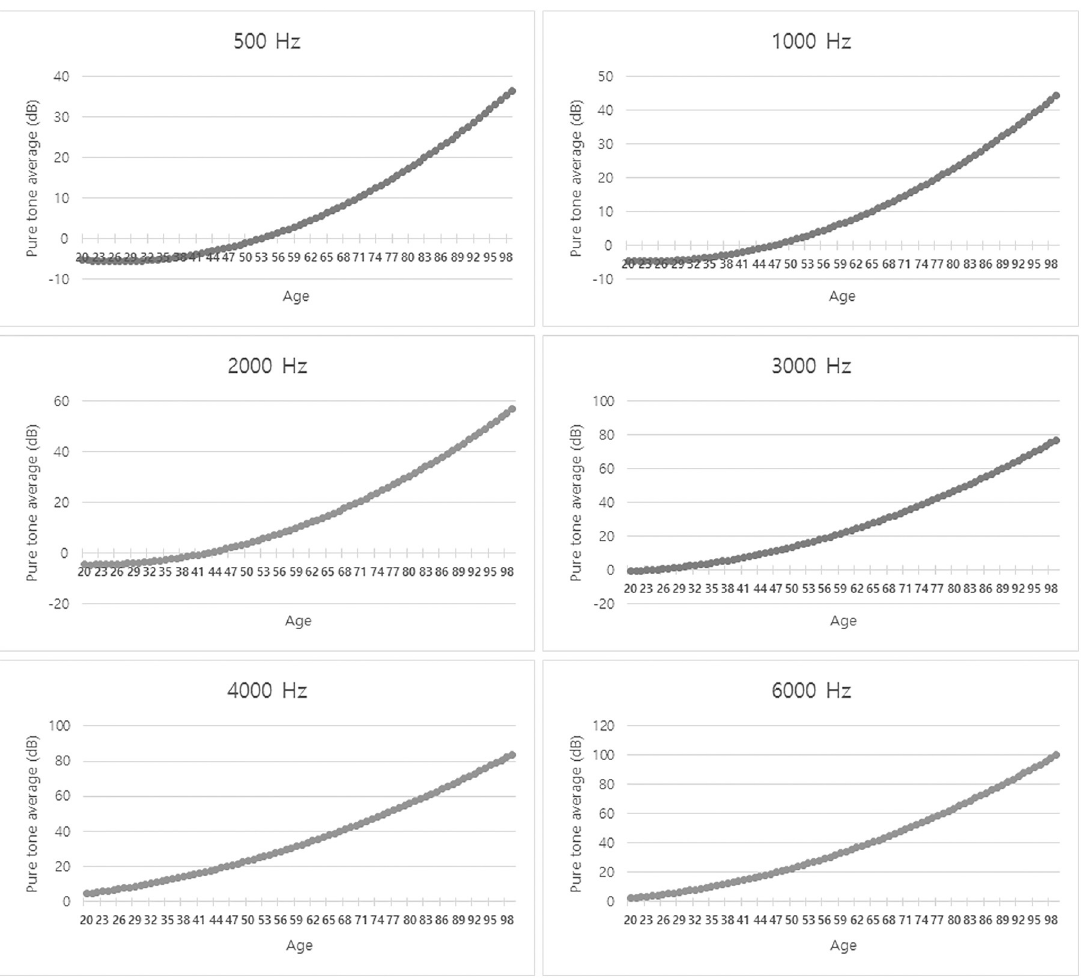
Fig 1. Pure tone average in the better ear at each age (500 Hz, 1000 Hz, 2000 Hz, 3000 Hz, 4000 Hz, and 6000 Hz). The average value was increased with age at all frequencies, especially at high frequencies.